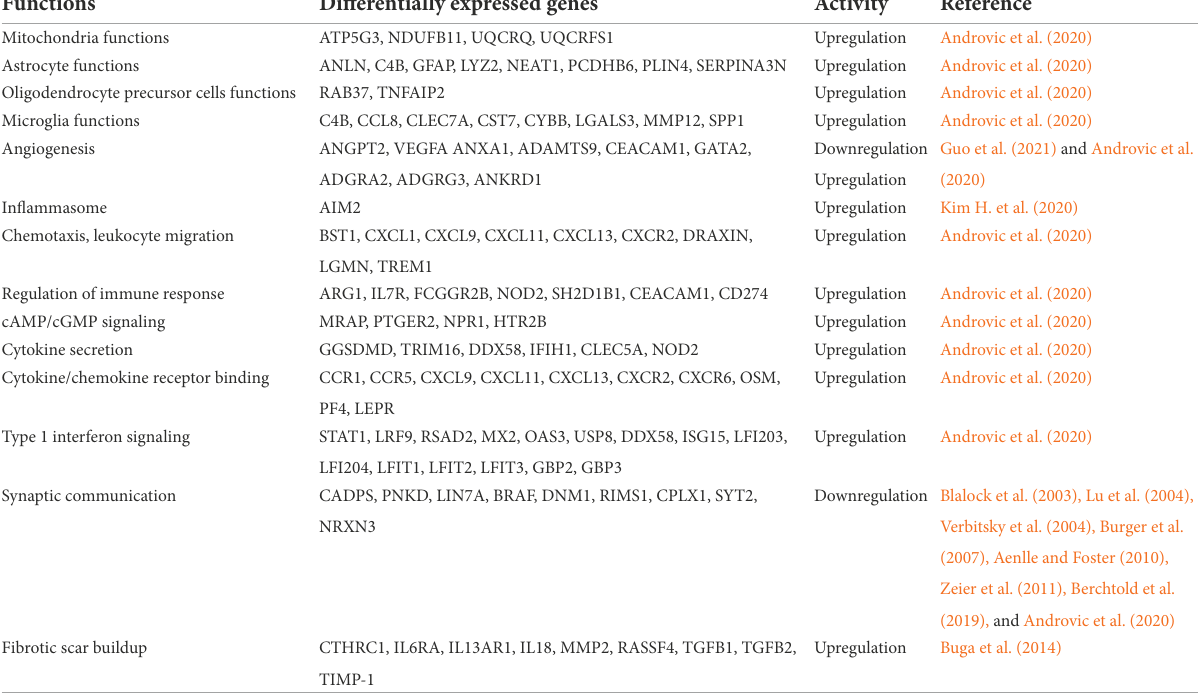
TABLE 1 Age-dependent transcriptional profile